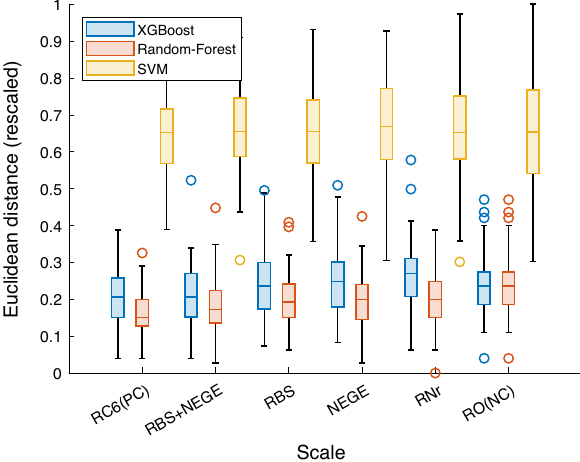
Figure 1. Mean distances between true and predicted matrices for prediction from RC6, RBS & NEGE (Combined), RBS, NEGE, RBS + NEGE (Reduced; RNr), and Random Observations (Negative control). Data were rescaled between 0 and 1.